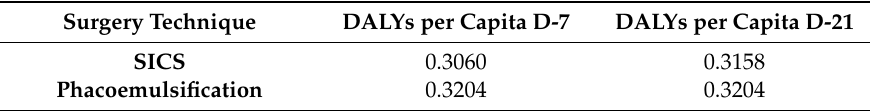
Table 4. Number of Disability-Adjusted Life Years (DALYs) Per